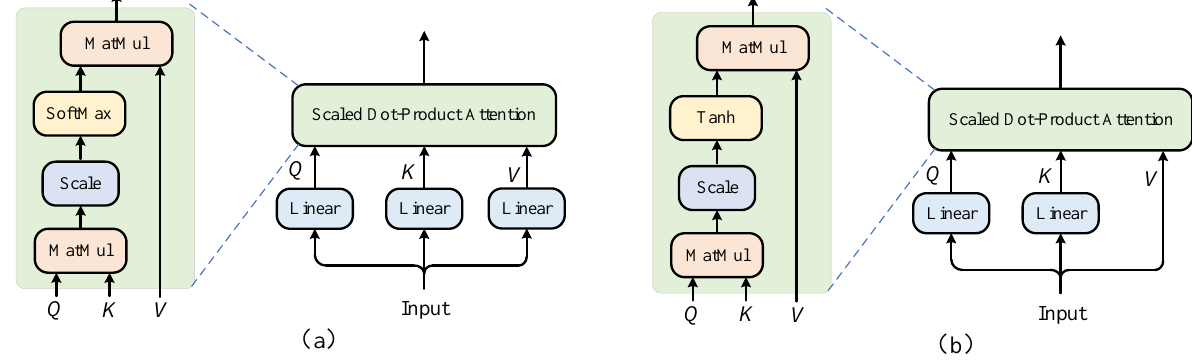
Figure 1. ( a ) Original structure of self-attention; ( b ) improved structure of